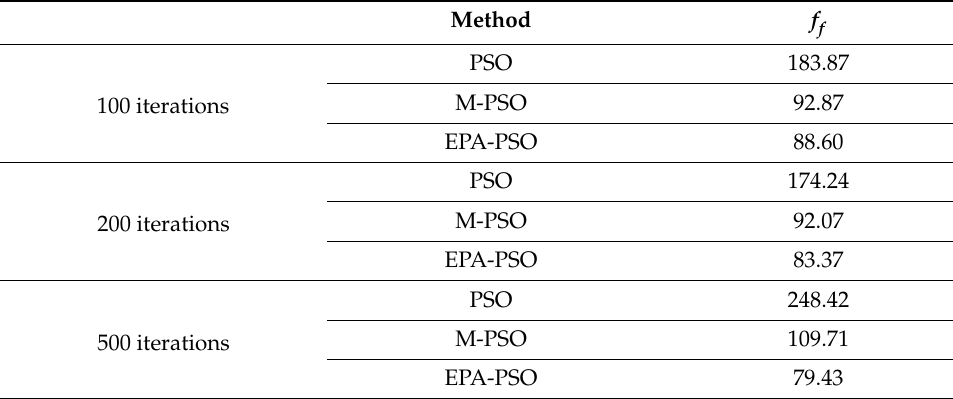
Table 4. The table of fitness